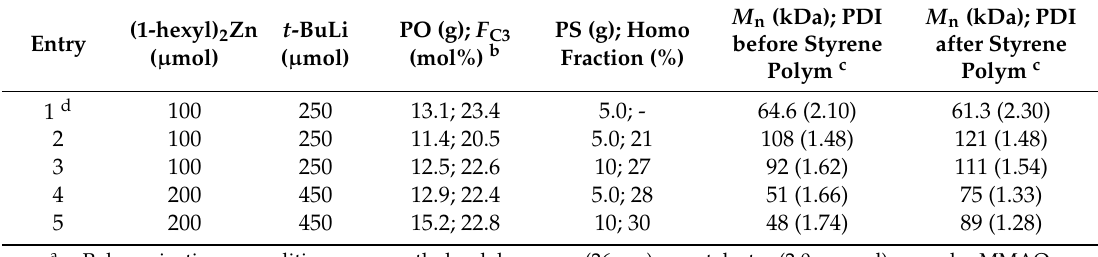
Table 1. Results for preparation of poly(ethylene- co -propylene)- b -PS a